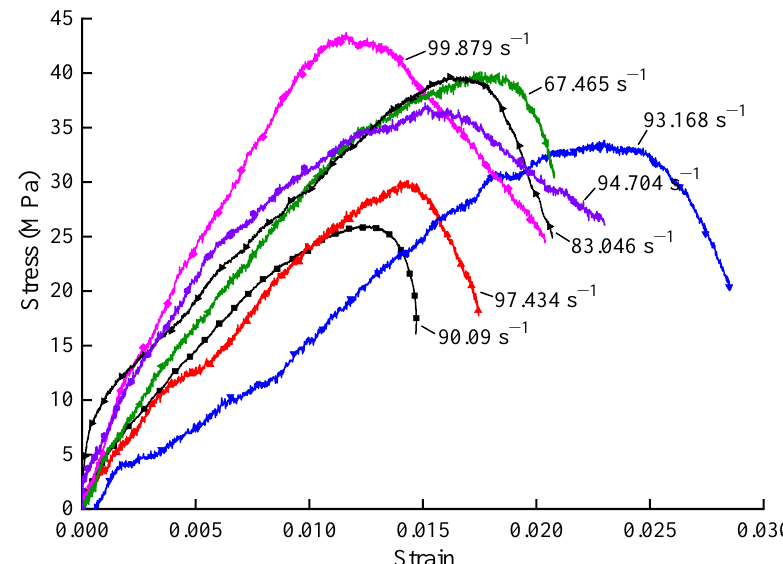
Figure 5. Stress-strain curves of typical hard coal specimens.